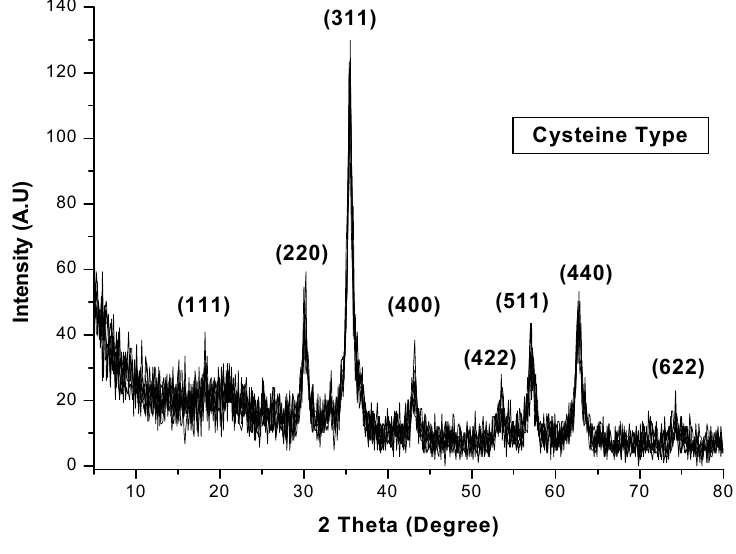
Figure 3. Powder X-ray diffraction (XRD) pattern of cysteine-sorbent nanoparticles.